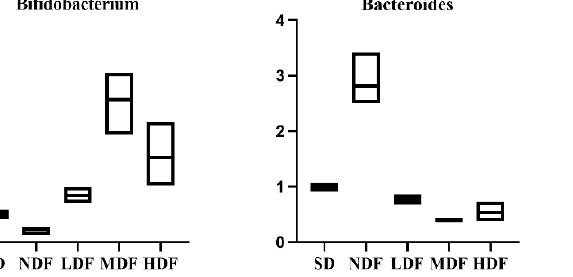
Figure 6. Relative expression of fecal flora in each group of mice.